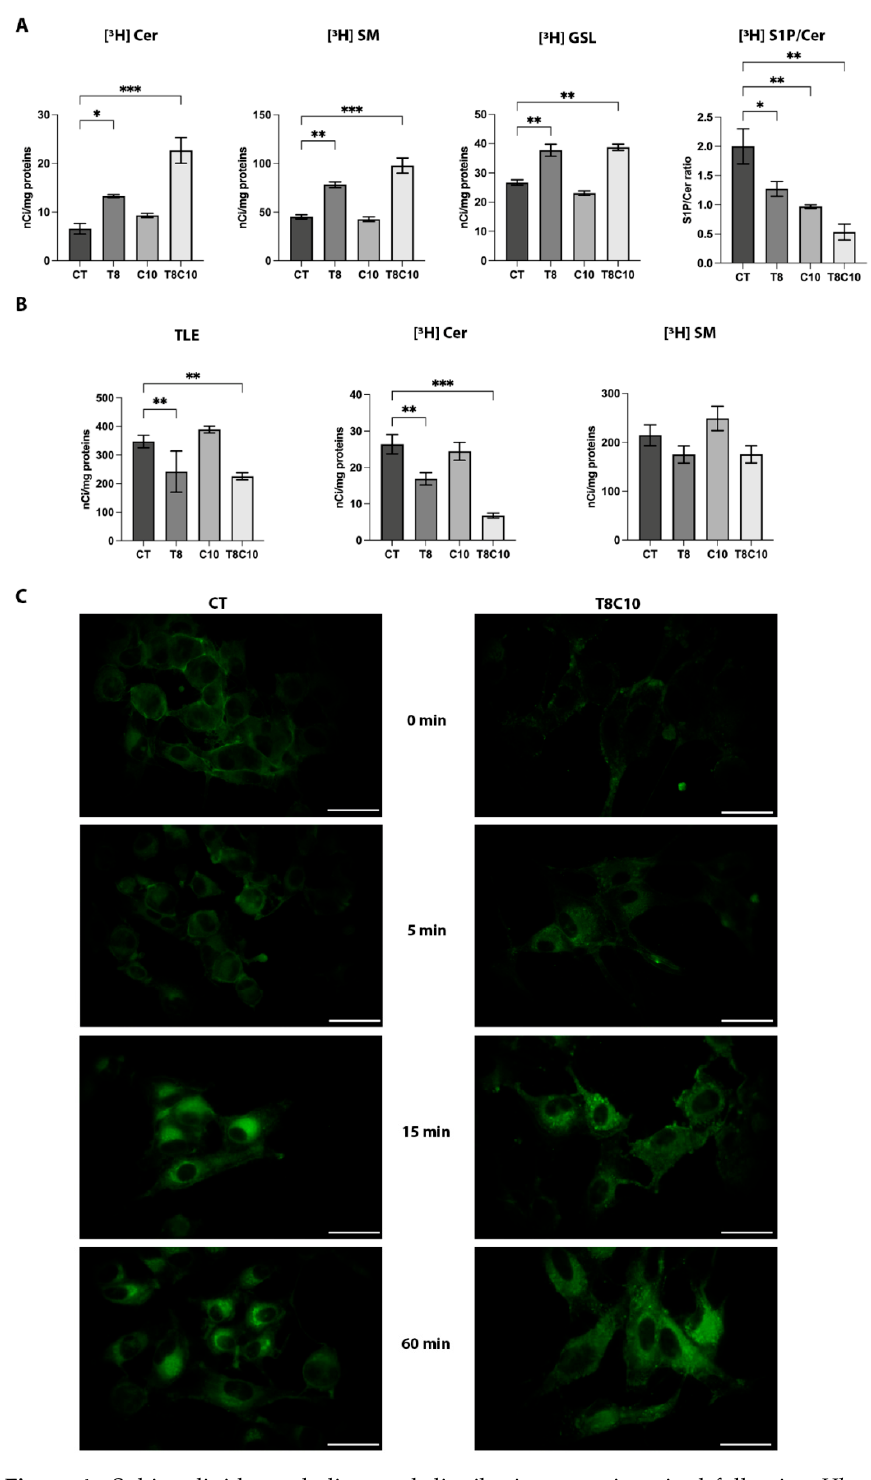
Figure 4. Sphingolipid metabolism and distribution were impaired following Hh and HDAC6 inhibition. ( A ) Radioactivity distribution among different sphingolipids after [1- 3 H]sphingosine administration at the metabolic steady state in U87-MG cells untreated (controls, CT) or treated with 8 µ M of TubA (T8), 10 µ M of cyclo (C10), and 8 µ M of TubA + 10 µ M cyclo (T8C10). Data are presented as mean of nCi/mg protein ± standard deviation. ( B ) Radioactivity of the total lipid extract (TLE), ceramide (Cer), and sphingomyelin (SM) following 2 h of [ 3 H]SM administration in U87-MG cells CT or treated with T8, C10, or T8C10. Data are presented as mean of nCi/mg protein ± standard deviation. ( C ) Uptake and subcellular localization of fluorescent BODIPY-SM after treatment in